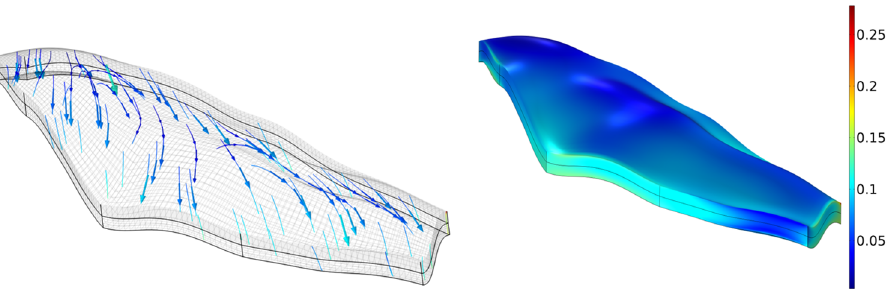
Figure 10. Steady flow field of ore ‐ bearing layer.